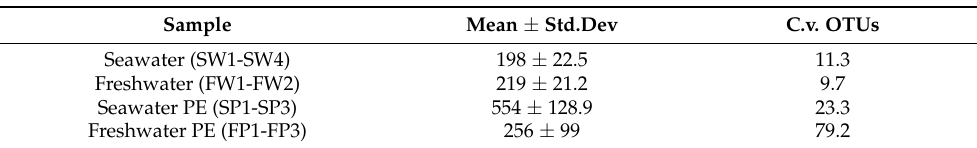
Table 3. Average number and coefficient of variation of OTUs detected in water and PE waste collected from freshwater and seawater.